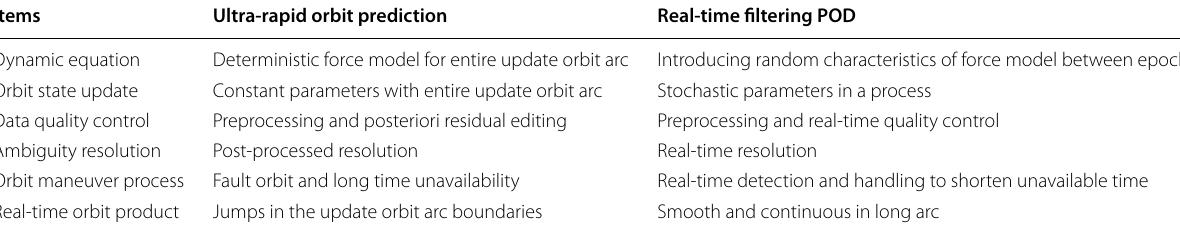
Table 1 Comparison of two real-time precise orbit determination